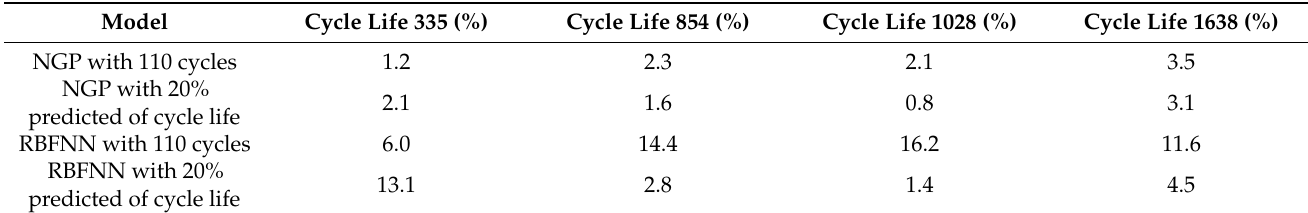
Table 3. MAPE comparison of failure cycle predicted by capacity curve of NGP and RBFNN